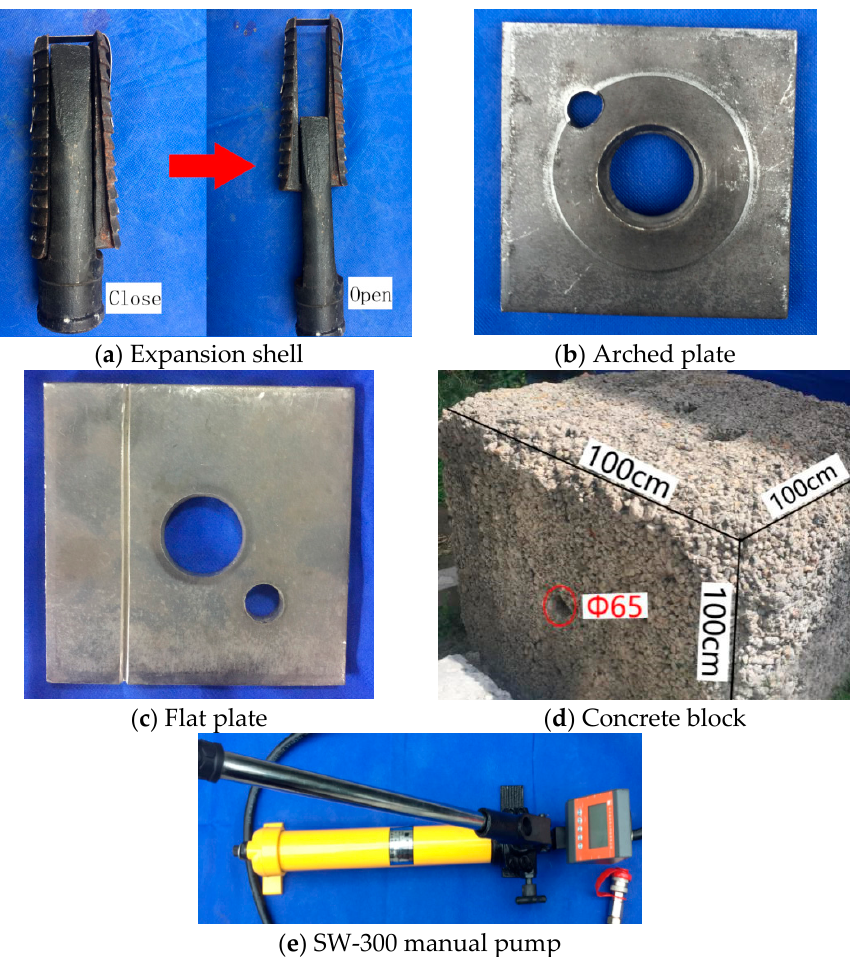
Figure 16. Experimental materials and instruments.